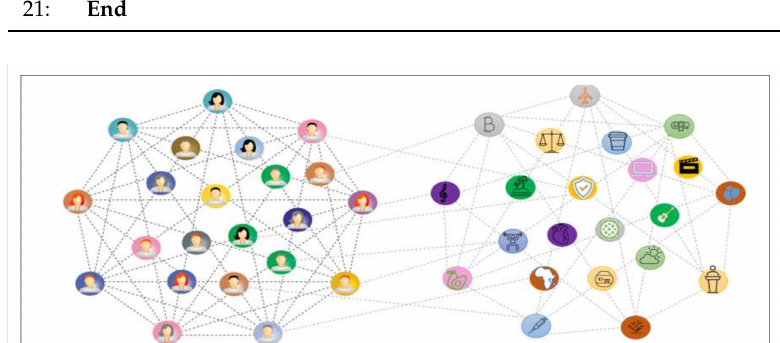
Figure 4. Users-Topic Heterogeneous Graph.